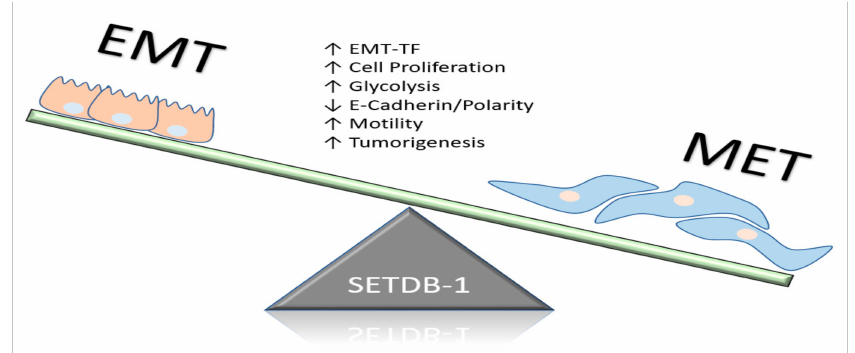
Figure 4. SETDB1’s influence on epithelial-to-mesenchymal transition (EMT) programs that initiate metastasis. This metabolic reprogramming altered the breast cancer phenotype and contributed to progression through acquisition of cancer stem cell